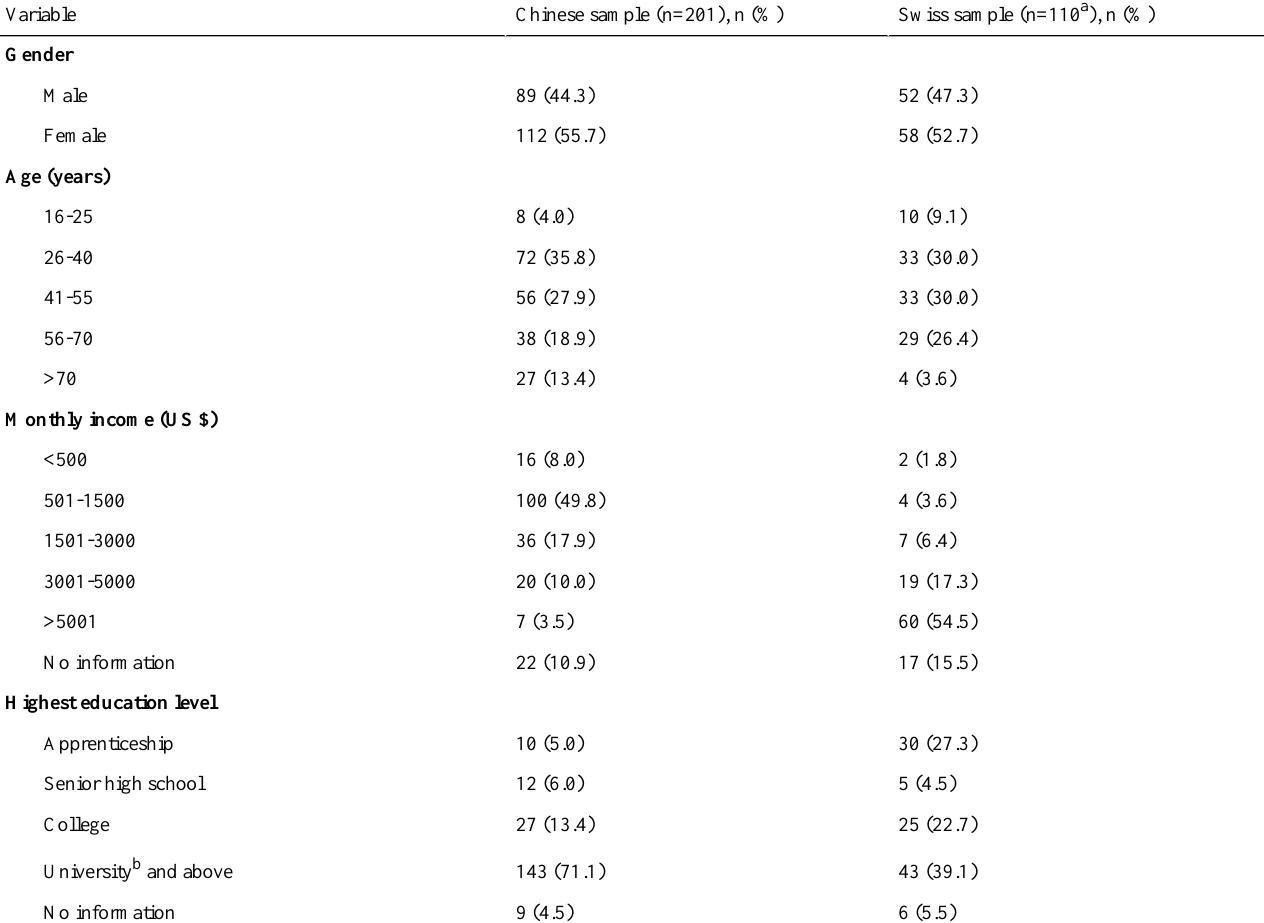
Table 4. Sample characteristics